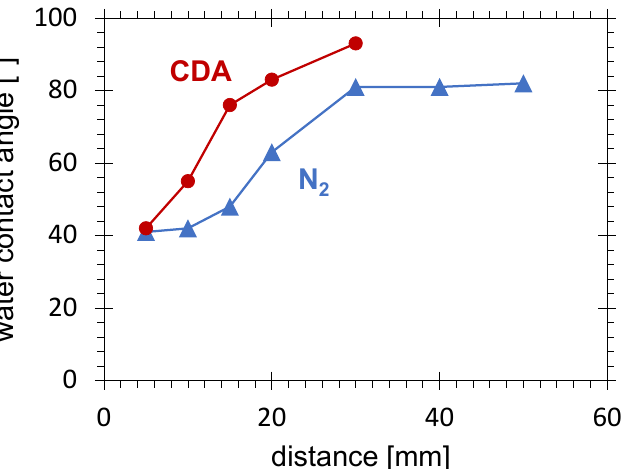
Figure 10. Water contact angle measured at the HDPE substrate surface after 2 min treatment with nitrogen and CDA PDD as a function of distance between the PCPG and the substrate, the PCPG input power of 8.0 W, and the gas flow of 10.0